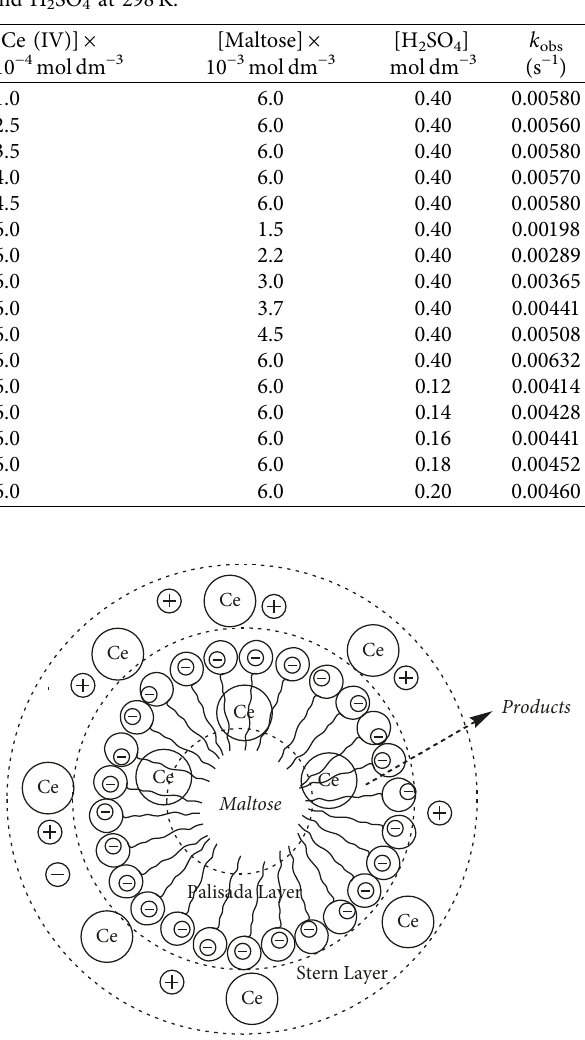
Scheme 2: The oxidation of maltose by cerium (IV) within the anionic surfactant micelle.